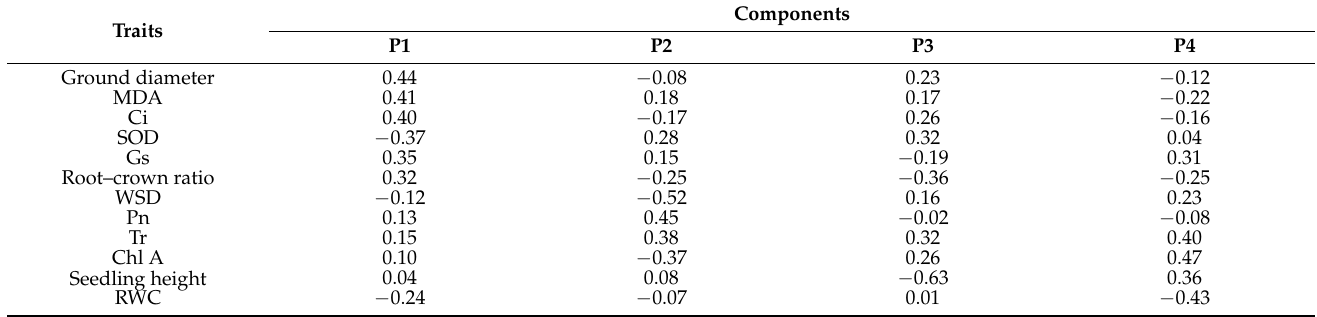
Table A2. The eigenvectors of the principal components under mild drought stress.